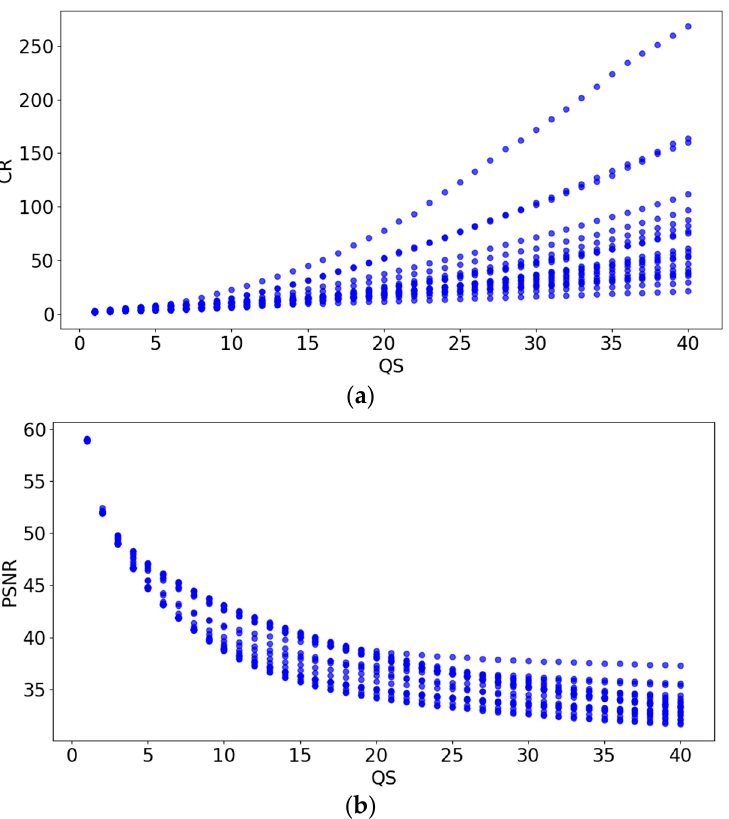
Figure 5. Dependences of compression ratio (CR) ( a ) and Peak signal-to-noise ratio (PSNR) ( b ) on quantization step (QS) for many image fragments for